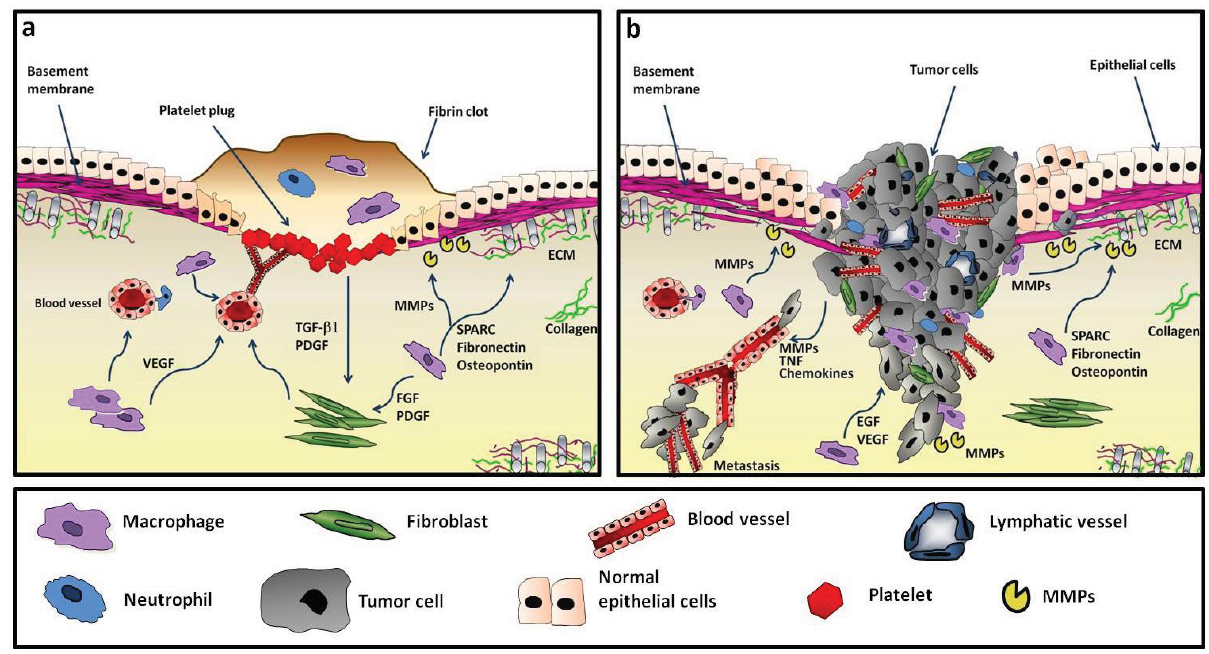
Figure 1. Comparison between wound healing and the reactive tumor microenvironment. Wound repair after tissue injury ( a ) is characterized by platelet aggregation, migration of leukocytes (neutrophils and macrophages) to the site of injury and by production of growth factors and cytokines involved in neo-angiogenesis and cell proliferation (e.g., PDGF, VEGF, FGF, TGF β ), and in ECM remodeling proteases (e.g., MMPs, SPARC, Fibronectin), thereby promoting wound healing and resolution. In the tumor microenvironment; ( b ) similar factors are produced by tumor-associated macrophages, fibroblasts and cancer cells, but neither with temporal control nor in a regulated manner. The continuous expression of stimulating growth factors and of proteolytic enzymes leads to a reactive milieu and enhanced angiogenesis that support tumor cell survival, proliferation and invasion of surrounding